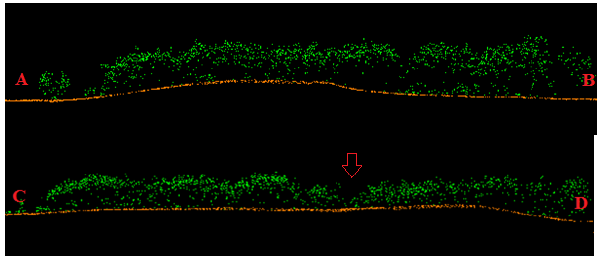
Figure 9. ALS point cloud profile and identification of some marks: cropmark and shape – object 3